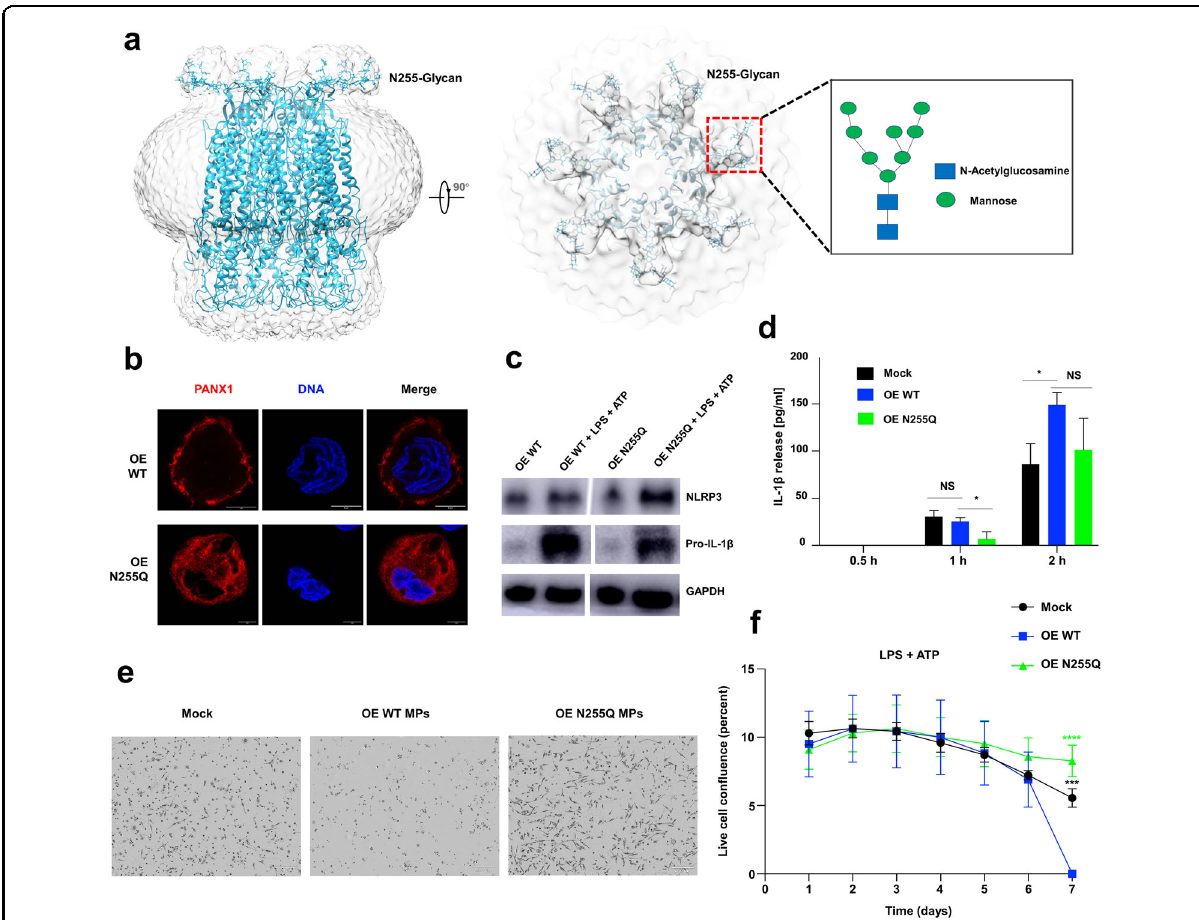
Fig. 2 Structural and functional analysis of the glycosylation modi fi cation in hPANX1. a Schematic representation of hPANX1 heptamer in light blue docked into the cryo-EM density map. The middle panel shows the top view of hPANX1 with glycosylation indicated. The right panel shows a magni fi ed view of the N-linked glycans (including two N-Acetylglucosamine and eight Mannose). b Representative images of the localization of WT and N255Q hPANX1 in THP-1-derived macrophages (MPs). The images were collected using the super-resolution STED mode. OE is the abbreviation of overexpression in all the fi gures. Scale bar = 5 µm. c Western blot analysis of the NLRP3 and Pro-IL-1 β in WT hPANX1 overexpressing and N255Q hPANX1 overexpressing MPs. MPs were treated with LPS (1 µg/ml) and ATP (3 mM) for 24 h. GAPDH was used as a loading control. d IL-1 β release from mock, WT hPANX1 overexpressing and N255Q hPANX1 overexpressing MPs. MPs were primed with LPS (1 µg/ml) overnight and stimulated with nigericin (10 µM) for 0.5, 1, or 2 h. IL-1 β release was measured by ELISA. Error bars represent s.e.m. for n = 3. * P < 0.05, NS not signi fi cant (one- way ANOVA followed by Dunnett ’ s test, OE WT set as comparison control). e Phase-contrast images of MPs stimulated by LPS and ATP. Images were acquired with an IncusyteS3 system on day 6. f Time course of live cell con fl uence of MPs. Image data were collected every 2 h and analyzed with an IncusyteS3 system. Error bars represent s.d. for n = 4. *** P < 0.001, **** P < 0.0001 (one-way ANOVA followed by Dunnett ’ s test, OE WT set